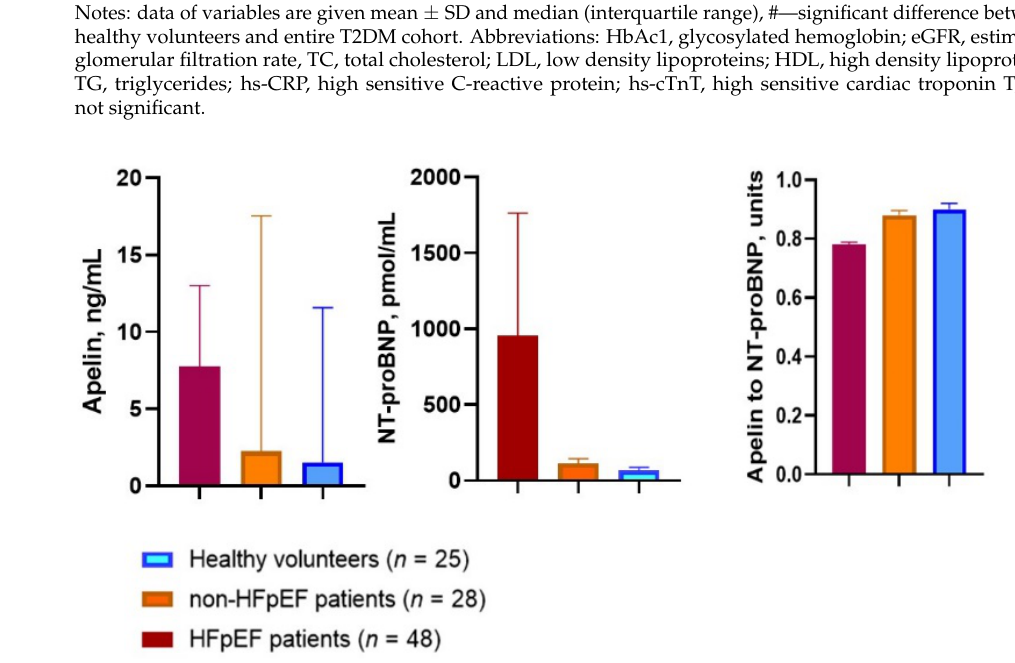
Figure 2. Apelin and NT-proBNP serum levels as well as the apelin-to-NT-proBNP ratio in T2DM patients with and without HFpEF in comparison with healthy volunteers. Abbreviations: HFpEF, heart failure with preserved ejection fraction; NT-proBNP, N-terminal fragment of brain natriuretic